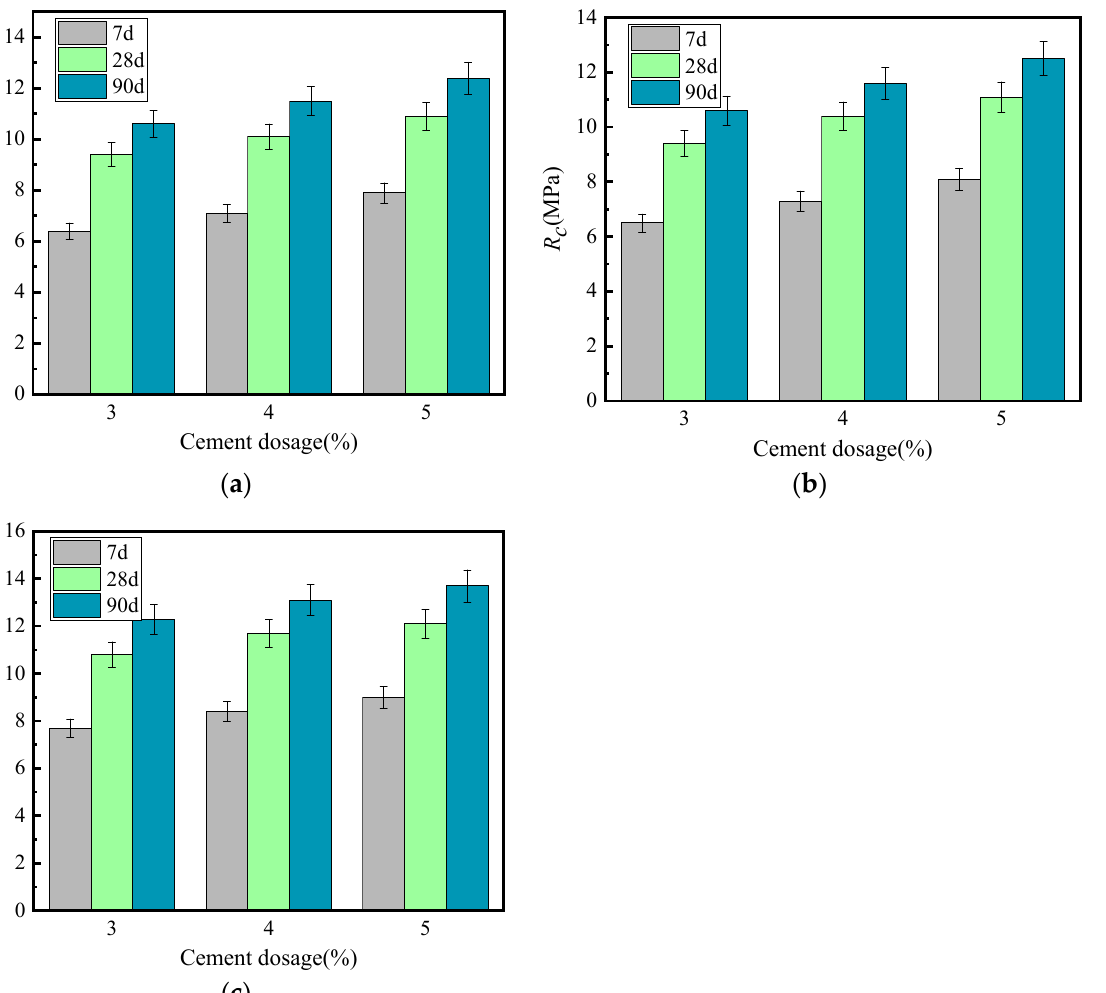
Figure 5. Growth law of unconfined compressive strength under different cement dosages. ( a ) GF1, ( b ) GF2, ( c ) VGM-30.